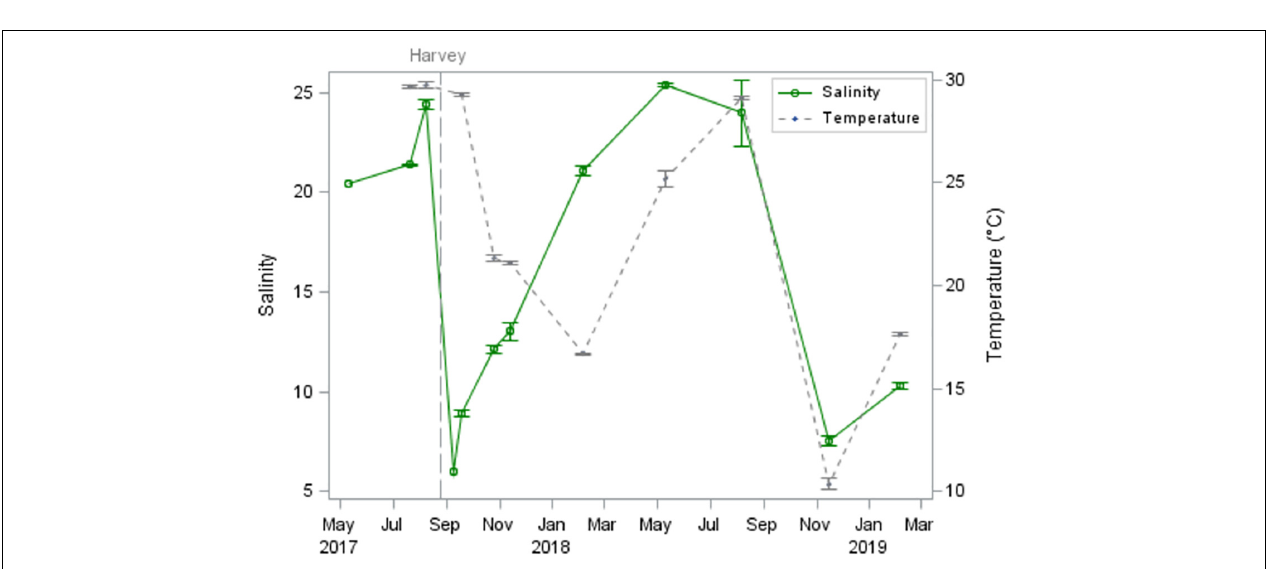
FIGURE 2 | Mean salinity and temperature in St. Charles Bay, TX, measured from May 2017-February 2019. Hurricane Harvey indicated by vertical dashed